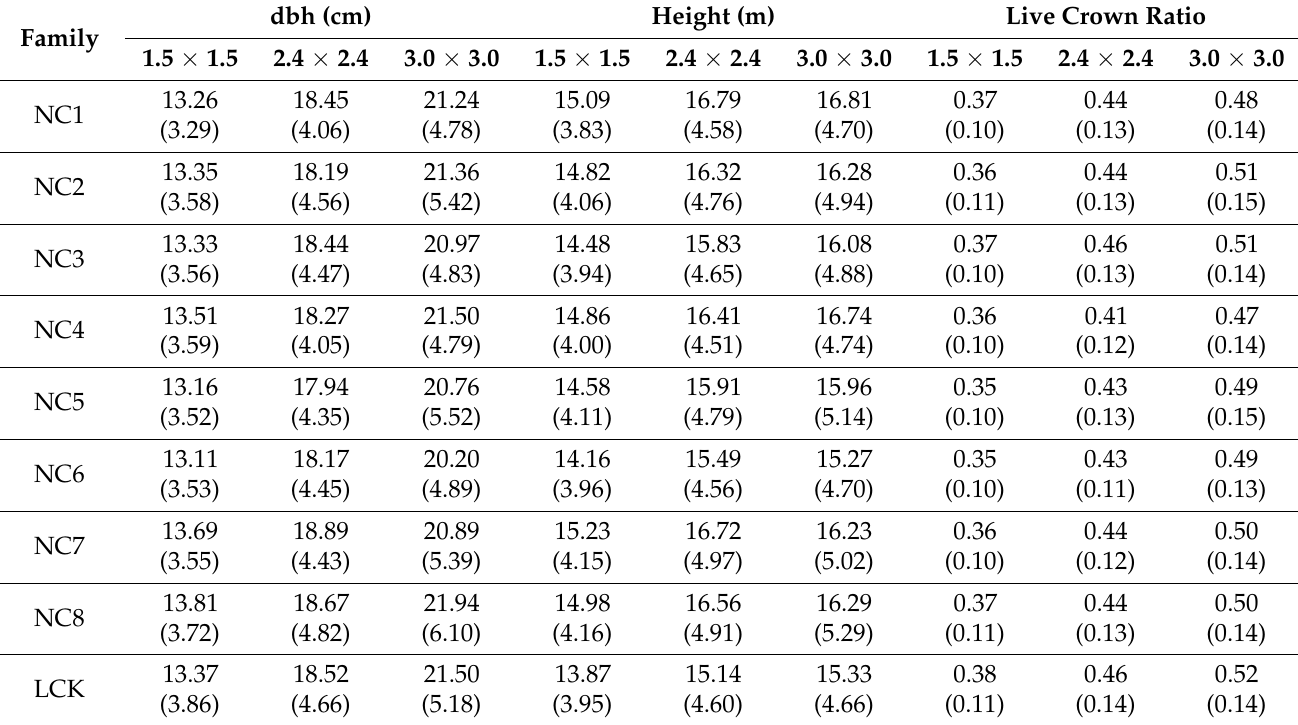
local check (LCK) family, respectively. Summary statistics of individual tree dbh, height, and crown ratio on family level are presented in Table 1. Table 1. Mean and standard deviation (in parenthesis) for tree-level variables by spacing and family. NC8 is fast growing with small crown, NC4 and NC7 are fast growing with large crown, NC3 and NC6 are slow growing with small crown, NC2 and NC5 are characterized by slow growth and large crown. LCK is a “local commercial check”.